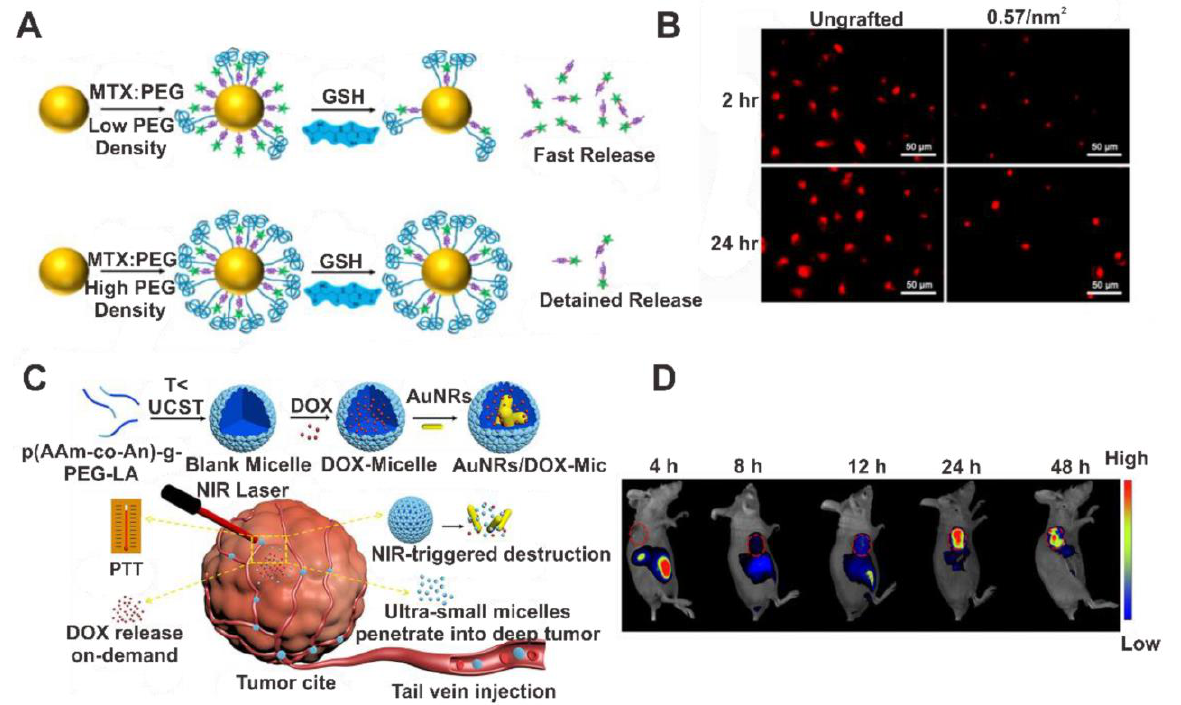
Figure 3. AuNP-polymer nanocomposites for use in drug delivery systems. ( A ) PEG density- dependent MTX release. ( B ) Live-cell fluorescent images of the MTX release from AuNPs of the